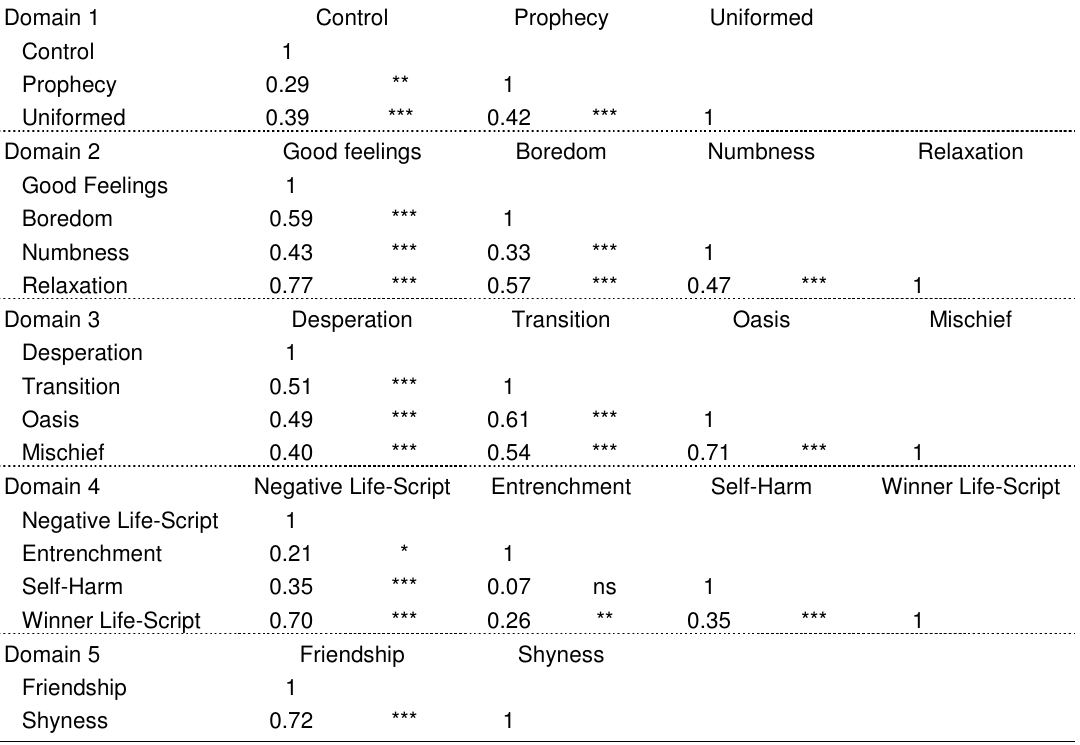
Inter-Relationships of the G-MAP Scales in Each Domain